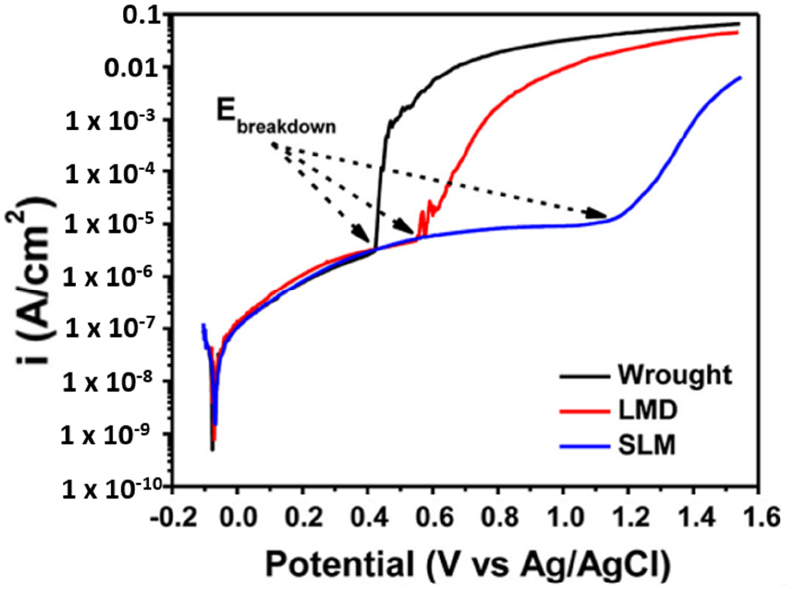
Figure 15. Corrosion measurement by potentiodynamic polarization curve of wrought, LMD, and SLM SS316L [37]. Lodhi et al. [56] compared the corrosion behavior of SLM and wrought alloy in three different simulated environments of human serum, PBS, and 0.9 M NaCl. In all the other